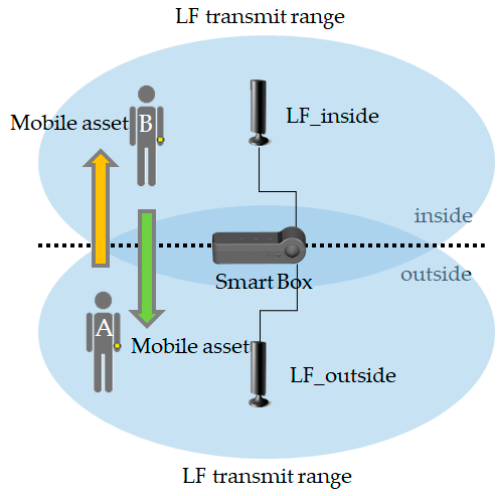
Figure 7. Identification of neighboring mobile assets.